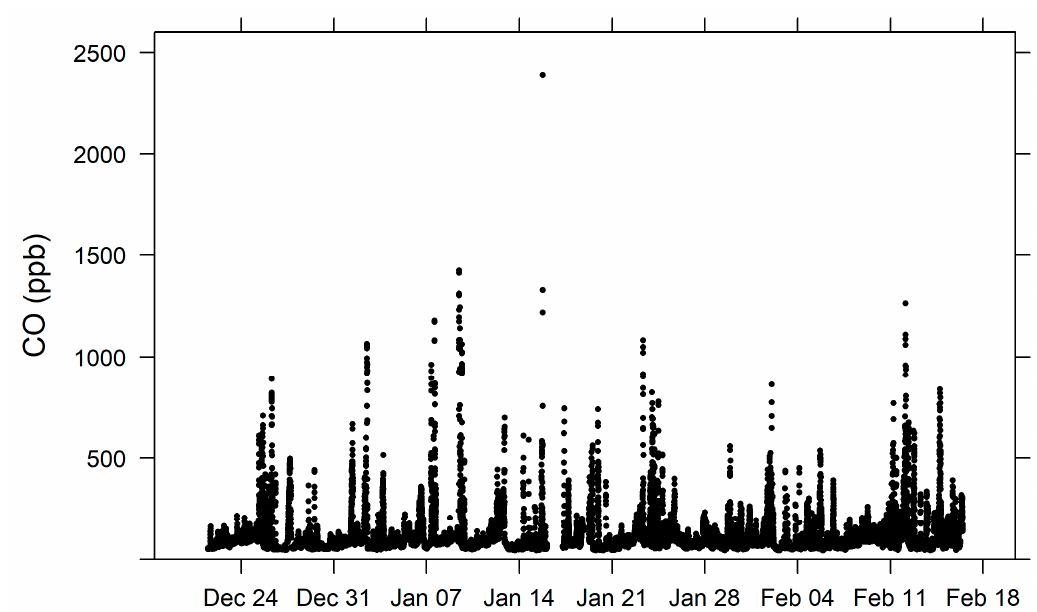
Figure 2. Time-series of three-minute average CO mole fractions (ppb) throughout the MUMBA campaign.